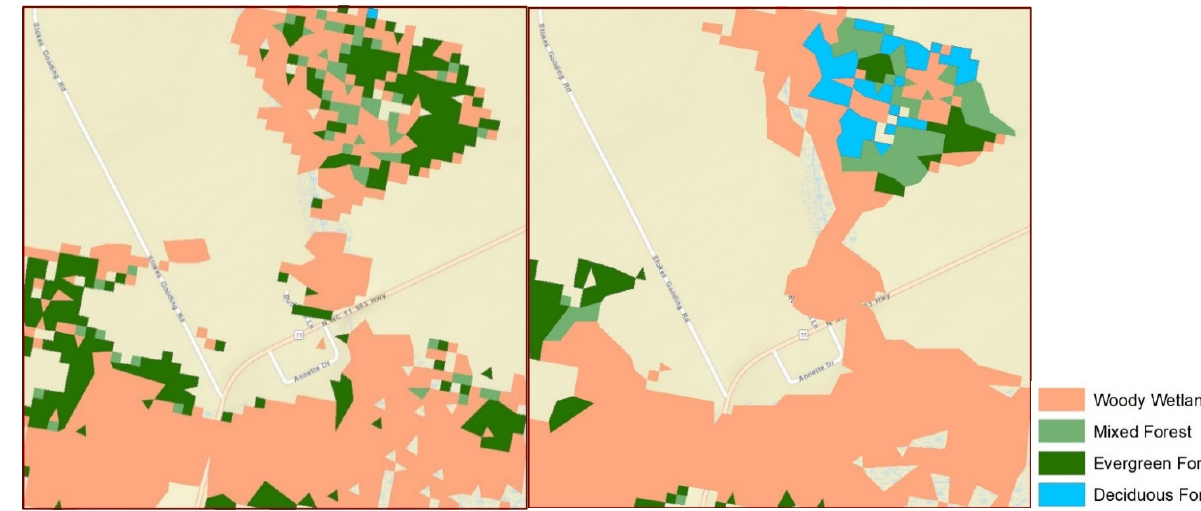
Figure 3. Study area: Location of different types of forest as reported in CDL (left panel) and NLCD (right panel).